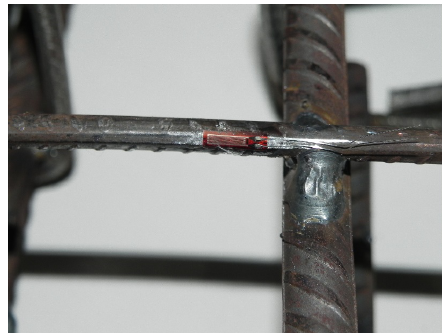
Figure 3. Steel bar instrumentation using strain gauge.